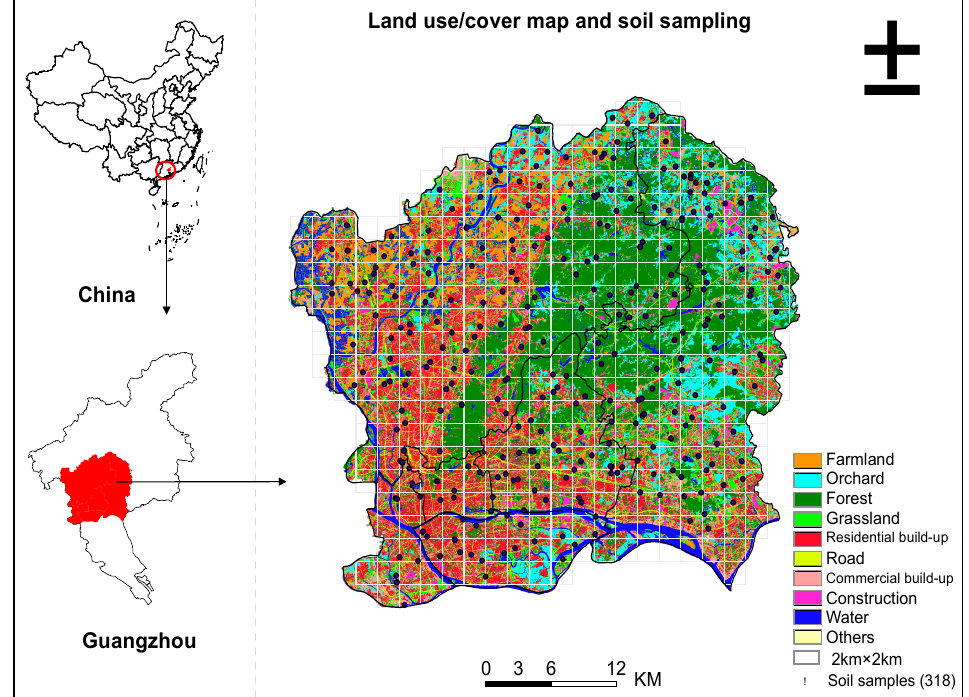
Figure 1. The location, land use, and cover map and soil samples.